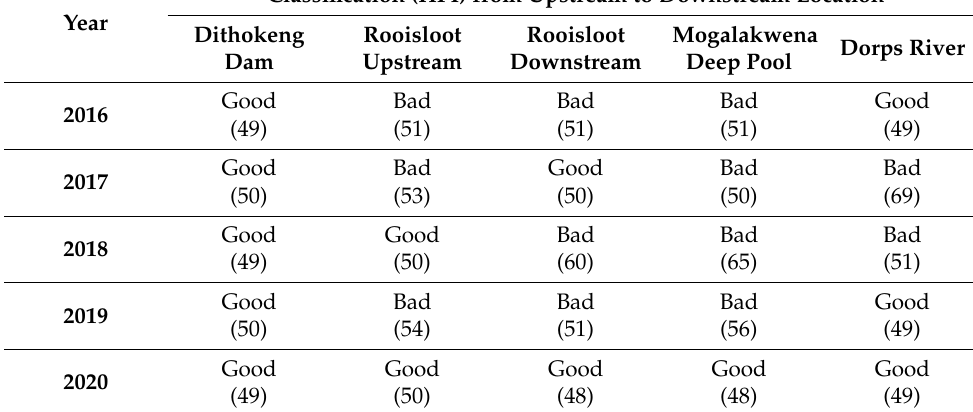
Table 5. Heavy metal pollution index (HPI)